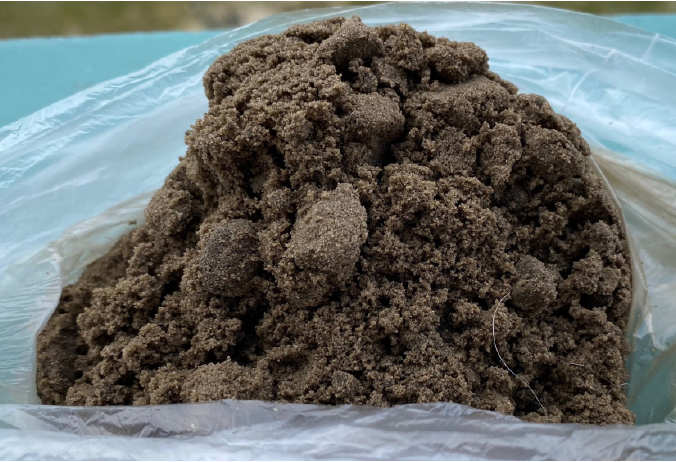
Figure 3. Sand obtained during well flushing in the workover process. Moreover, the geological structure of the reservoir in the central part is complicated by faults and fractures. The field is under development by the grid of horizontal wells with length of horizontal part of 1000 m (3300 ft, 0.62